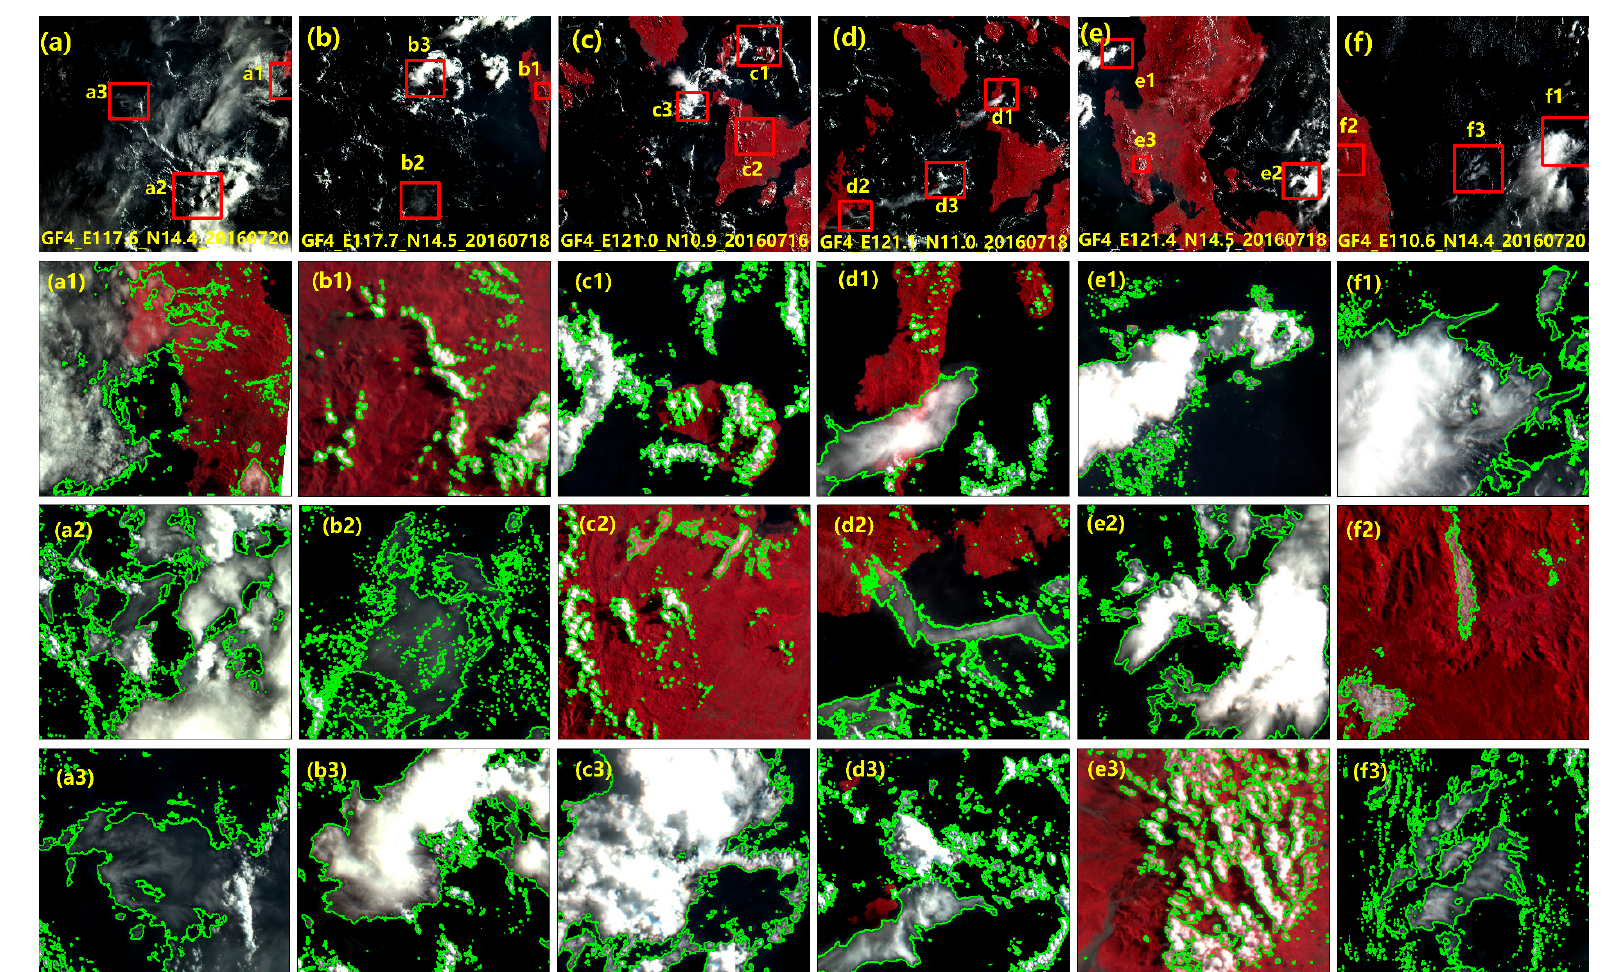
Figure 5. Visual verifications in the case of the coastal area of the SCS for GF-4 data. There are six blocks ( a , b, c, d, e and f ) that corresponded to the six data used, as presented in Figure 3 ( a, c, e, g, i and k ) and Table 2 (No. 1–6), respectively. The three magnified images (red boxes) below each block provide detailed information of that particular block ( a, b, c, d, e and f ), which mainly includes the cloud detection results for thick clouds, thin clouds, broken clouds, and low clouds in the study area.